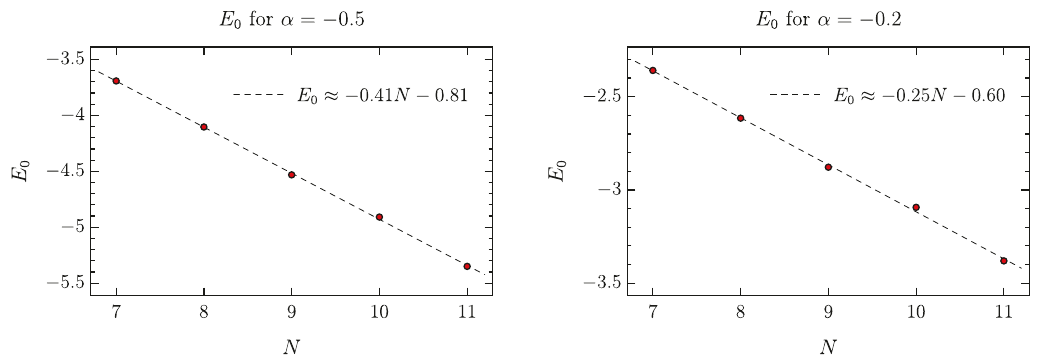
Figure 11 . Plots of the leading term in the ground state energy (6.2), A ( α, N ) , vs. N for α = − 0 . 5 (left) and α = − 0 . 2 (right). The linear fits determining the slope, E 0 ( α ) , are also